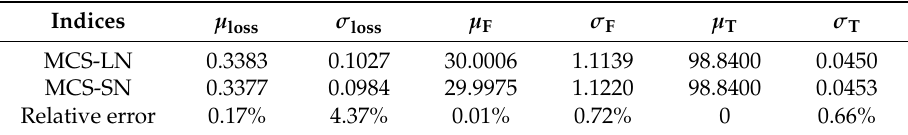
Table 2. Results of PEF for